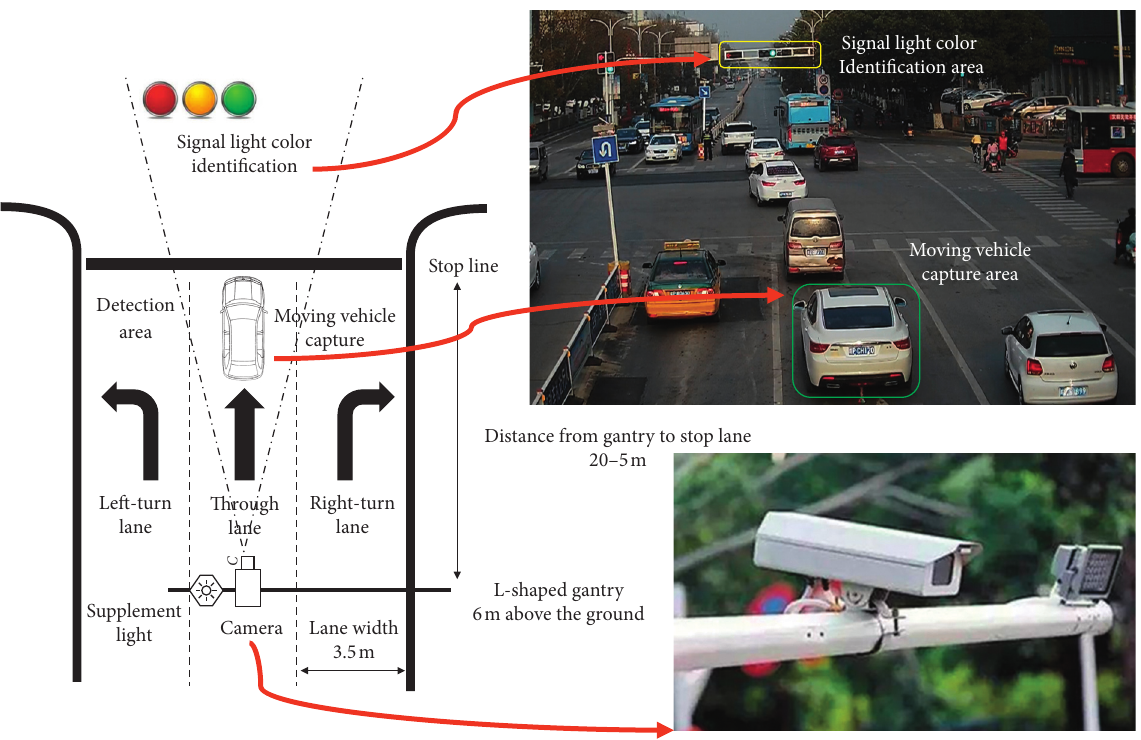
Figure 1: Front detection unit of an AVI